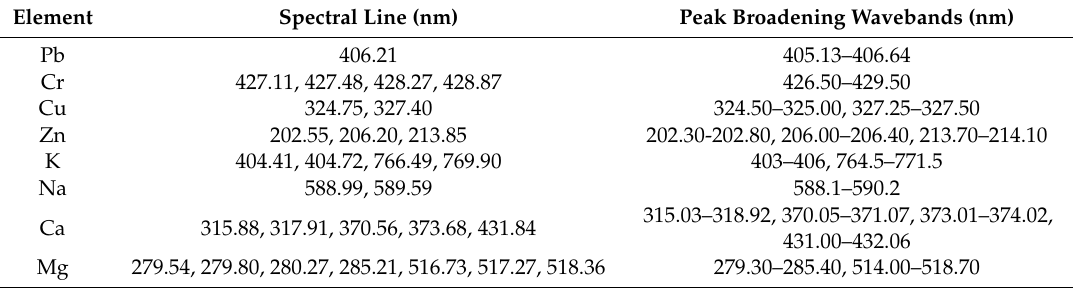
Table 2. Emission lines of agricultural biochar based on the database of NIST.